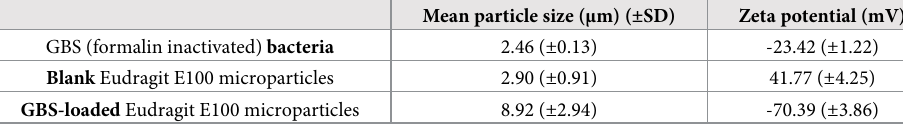
Table 1. Particle size measured by dynamic light scattering (mean ± SD), n = 12.